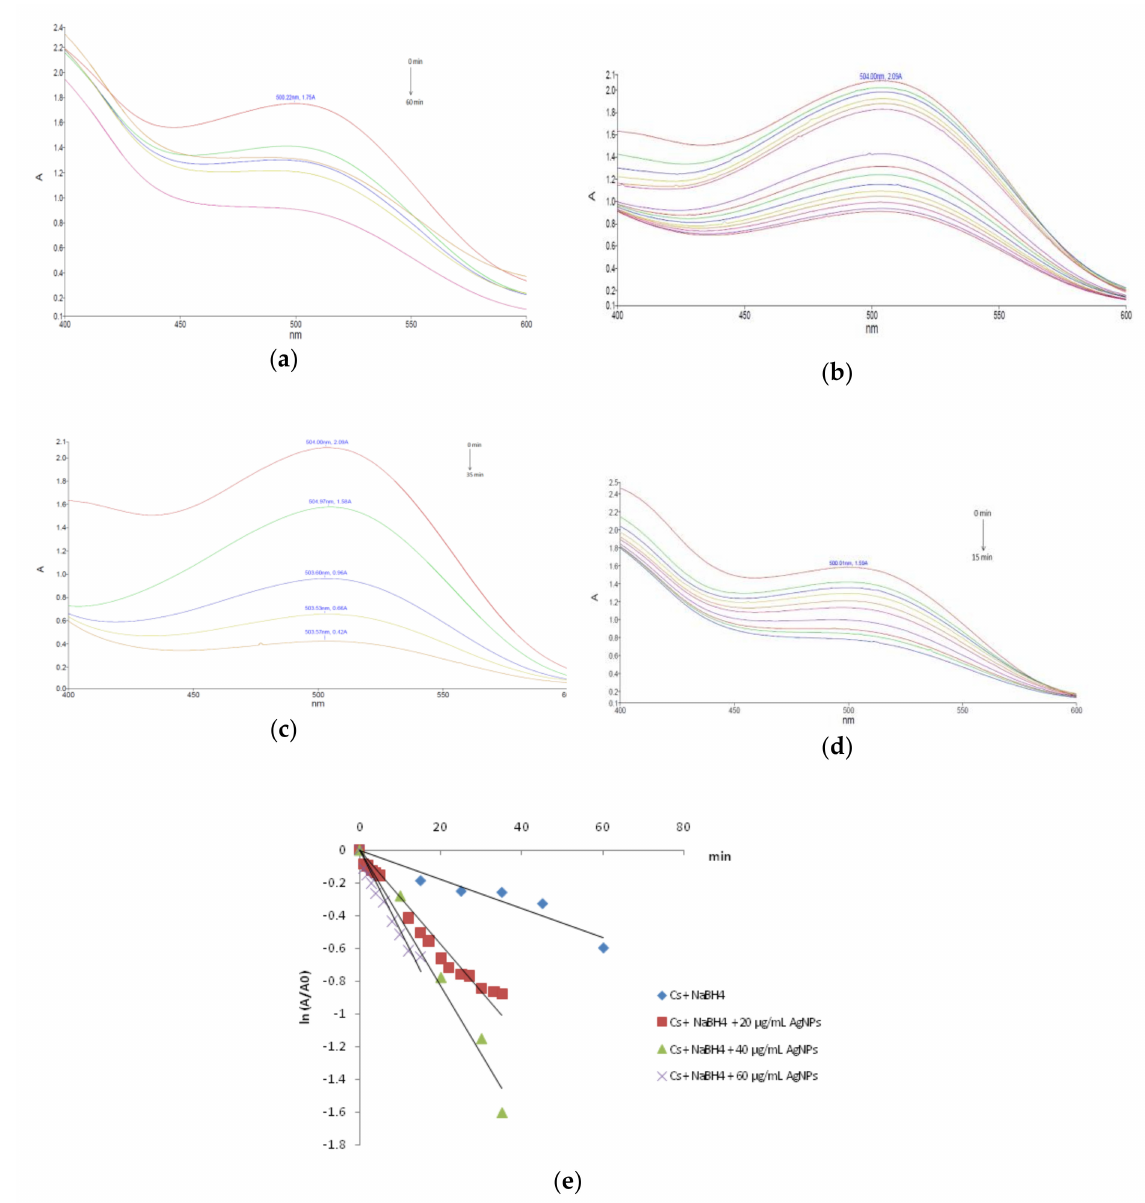
Figure 7. NaBH 4 mediated carmoisine degradation: ( a ) without catalyst; ( b ) in the presence of 20 µ g / mL AgNPs; ( c ) in the presence of 40 µ g / mL AgNPs; ( d ) in the presence of 60 µ g / mL AgNPs and ( e ) kinetics